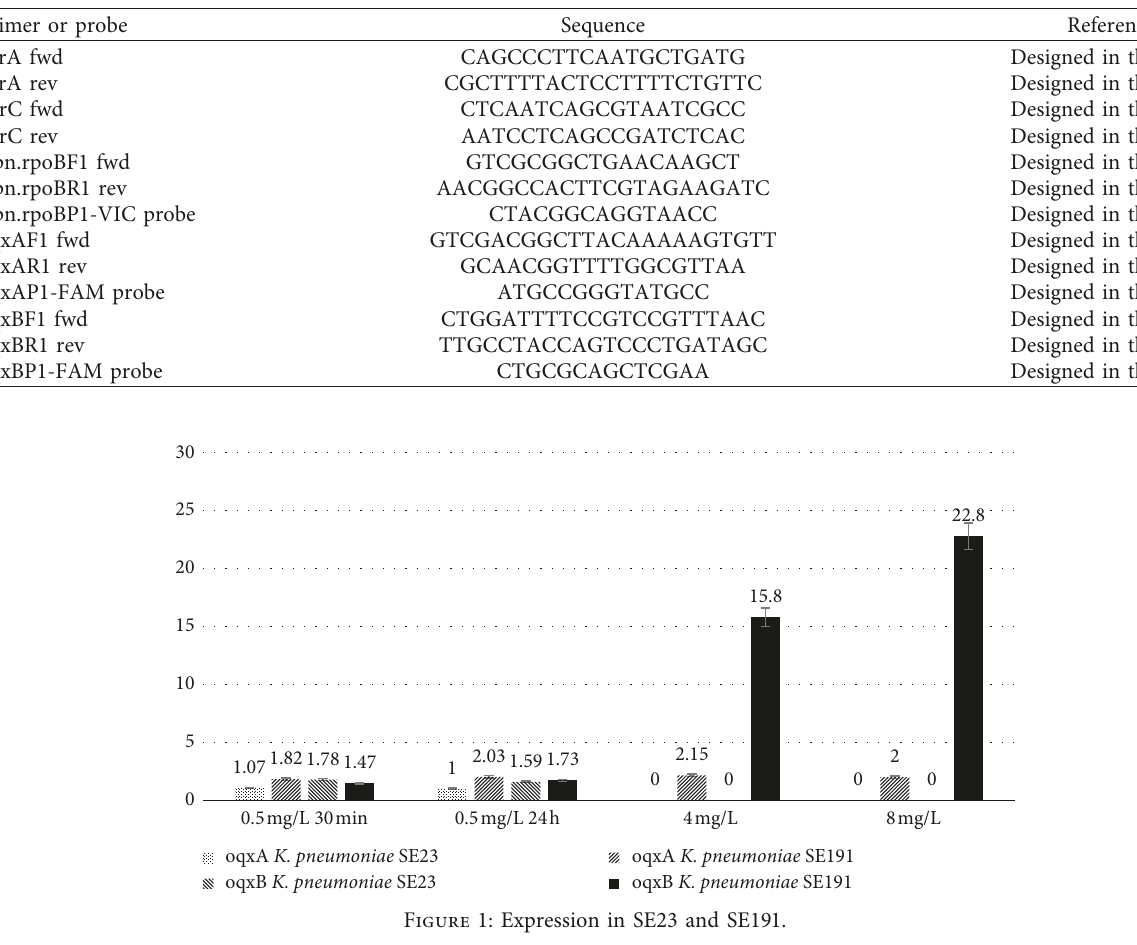
Table 1: Oligonucleotide primers and probes of this study.